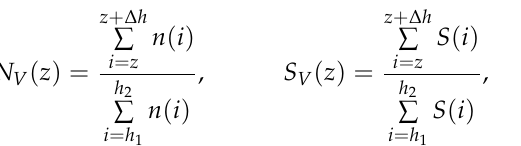
Figure 7. Plots of the karst pore structure parameters: ( a ) pore radius distribution, ( b ) pore area distribution, and ( c ) shape factor distribution.